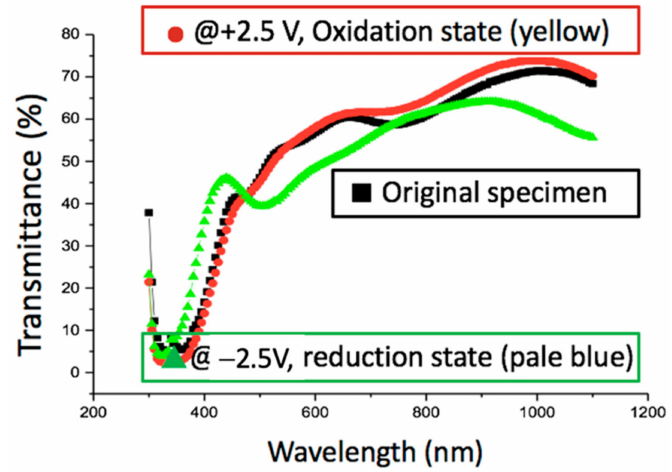
Figure 1. The transmittance of the V 2 O 5 thin film; the original sample, colored sample and bleached sample are indicated by squares, circles and triangles, respectively.